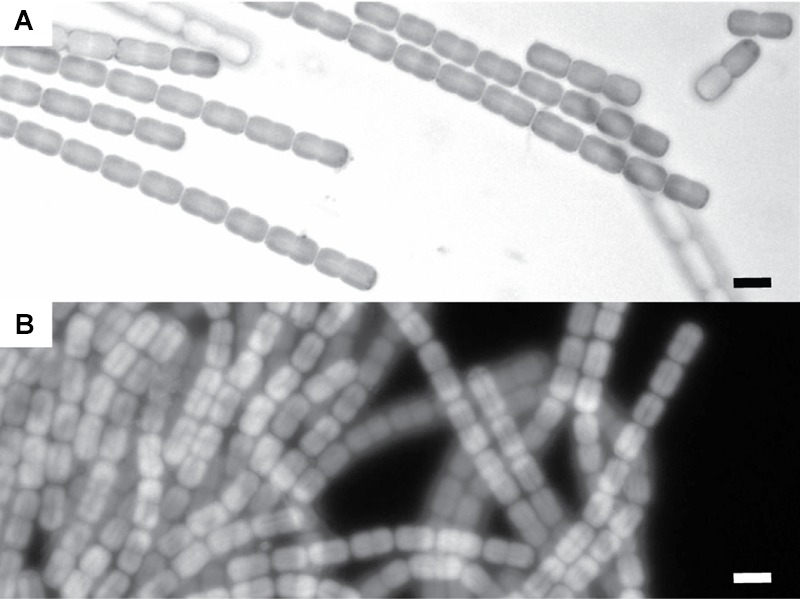
Microscopic images of the cyanobacteria dominating the cyanobacterial mats in the Frasassi sulfidic springs. (A) Light microscope image. (B) Auto-flourescence image (Excitation maximum: 547 nm, Emission > 590 nm). The scale bars are 5 μm.